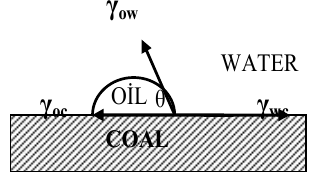
Fig.4 . Interfacial tensions and contact angle